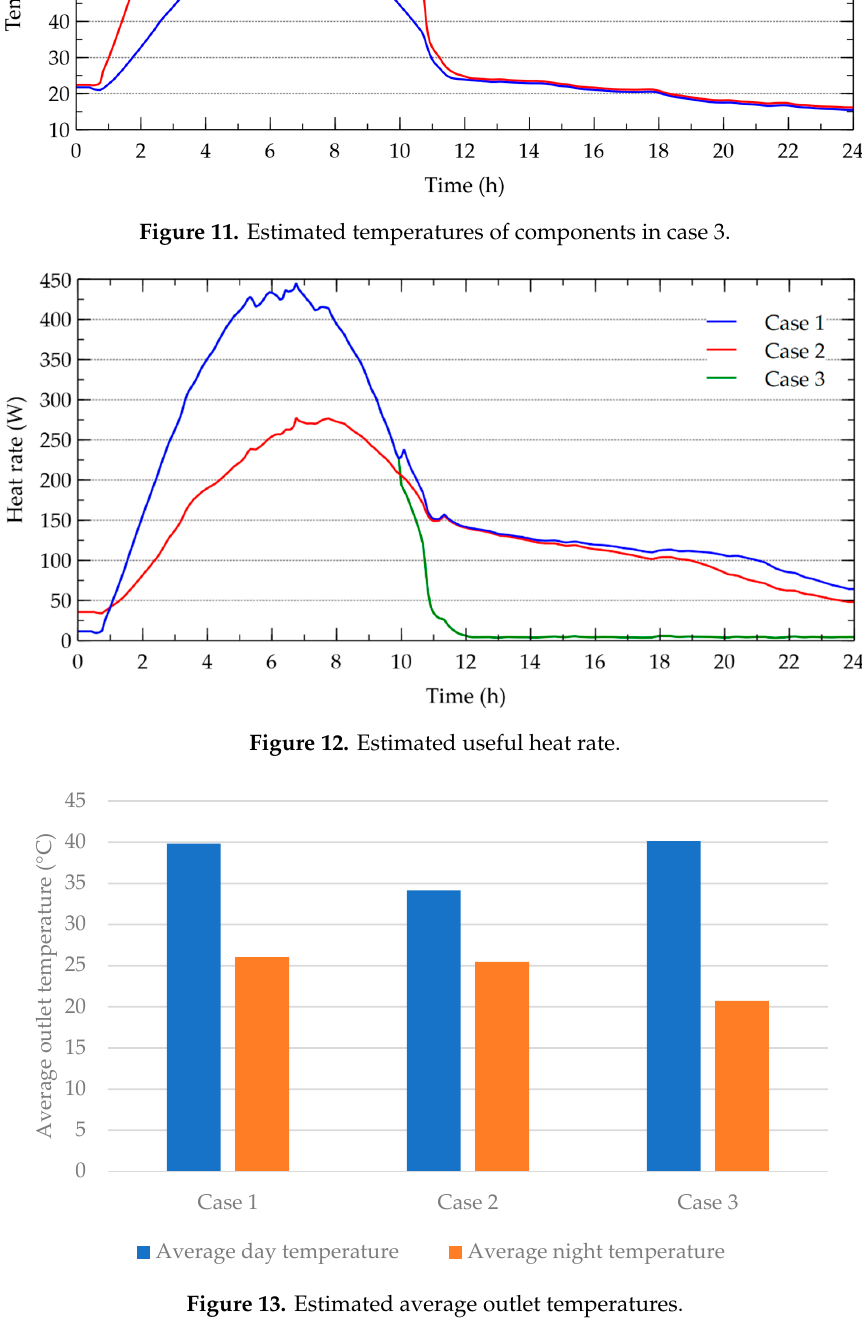
Figure 14. Estimated total losses.